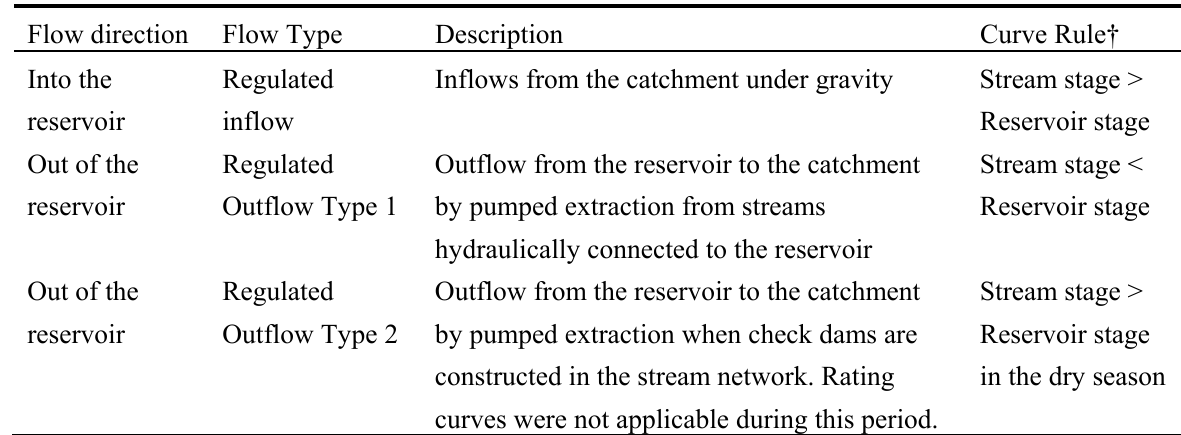
Table 1. Description of the surface flow rating